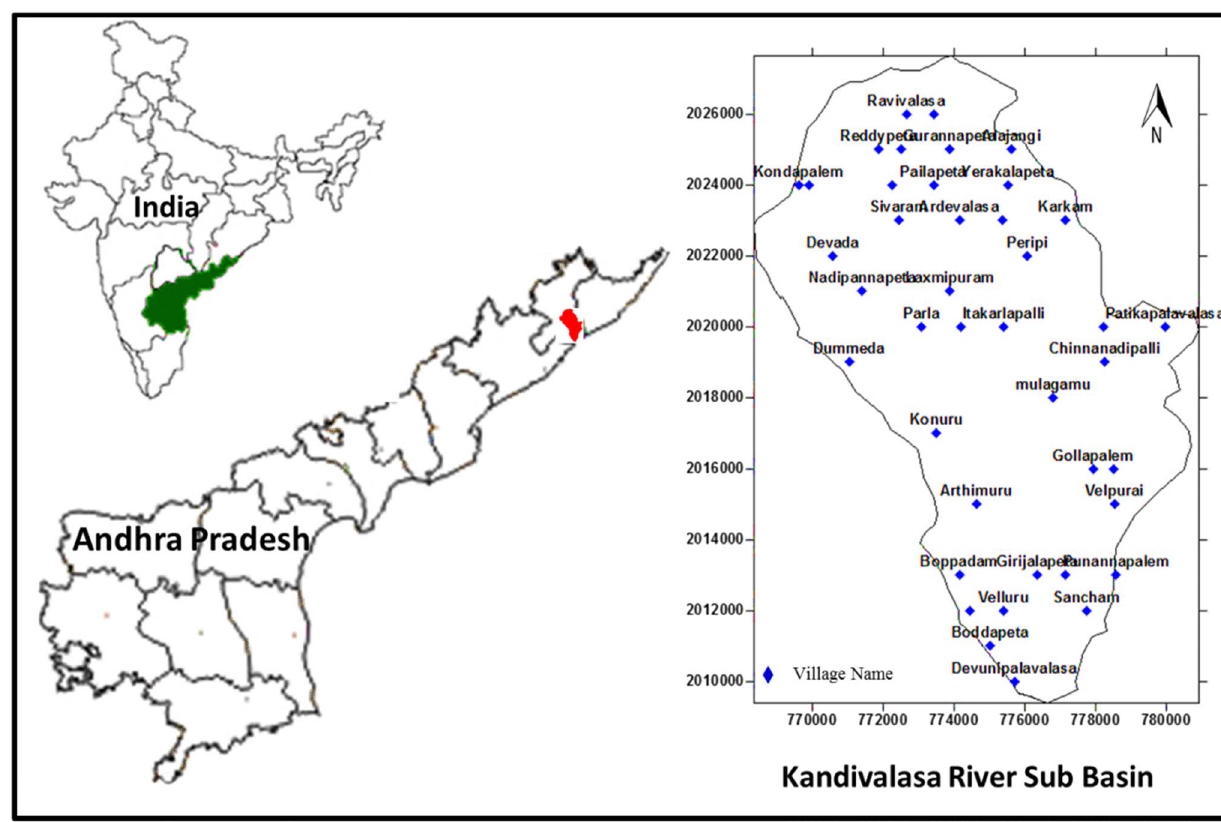
Fig. 1 Location of Kandivalasa river sub-basin in the Vizianagaram district, Andhra Pradesh,